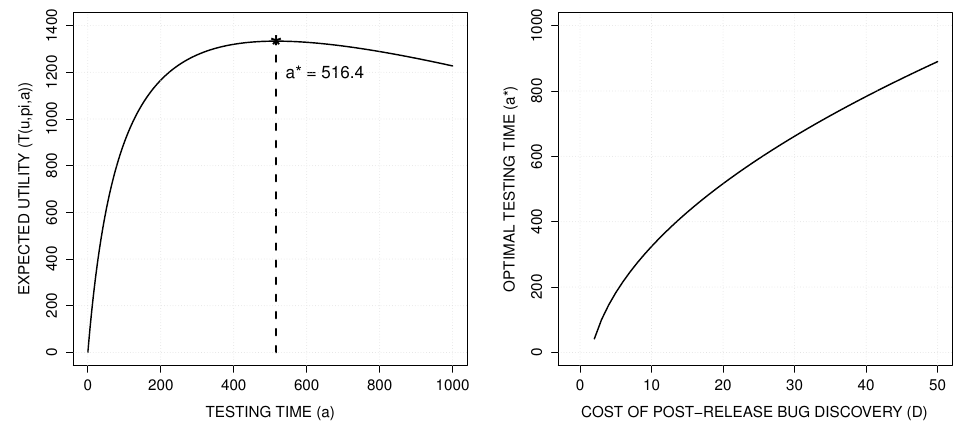
Figure 8. Expected utility as a function of time ( left ) and optimal testing time as a function of post-release bug cost ( right